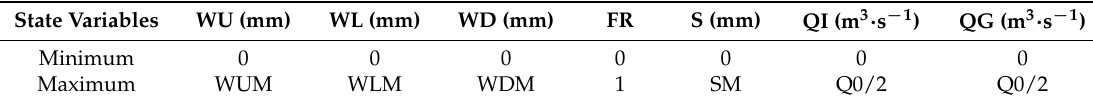
Table 2. The ranges of state variables of the Xinanjiang